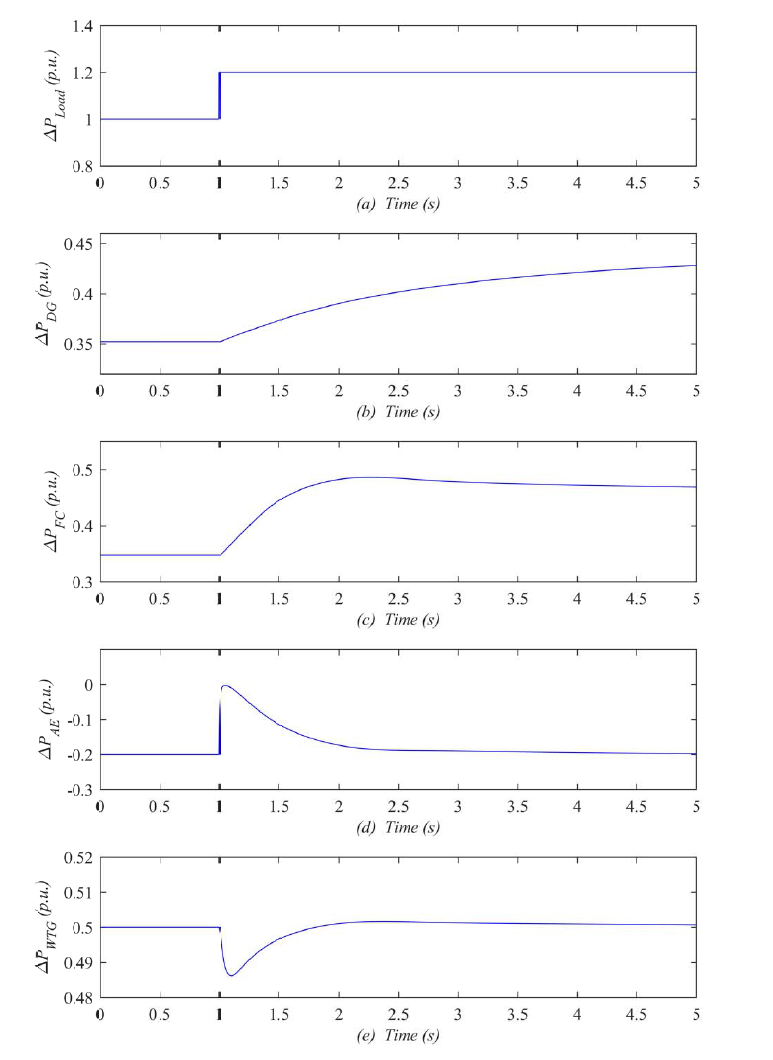
Figure 14. Transient power response of each energy sources with +0.2 p.u. change of load demand based on ILADRC controller. ( a ) Load power change; ( b ) Dynamic response of DG; ( c ) Dynamic response of FC; ( d ) Dynamic response of AE; ( e ) Dynamic response of